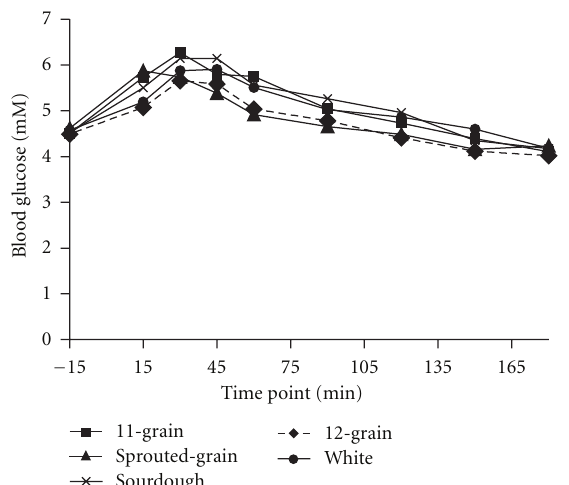
Figure 1: Fasting and postprandial glucose responses to the ingestion of 50 g available carbohydrate of the test breads. Data are means. Standard errors are not included for clarity, n = 12. Test bread was ingested after collection of fasting blood sample at time point − 15 min. Significant overall treatment e ff ects were found in glucose responses to the breads (Sprouted-grain bread was lower than 11-grain ( P < 0 . 009), sourdough ( P < 0 . 001), and white